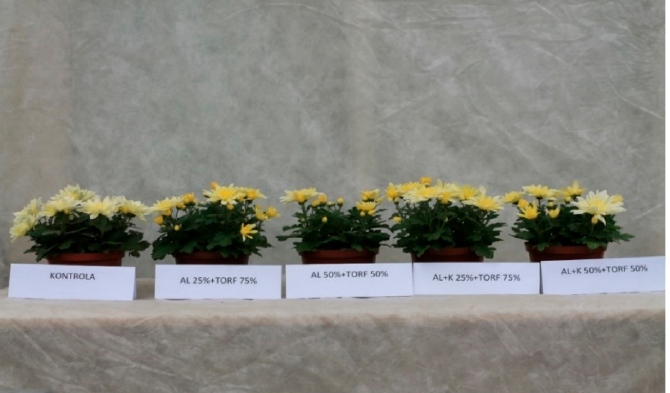
Figure 5. The quality of chrysanthemum (KONTROLA-control, AL 25% + TORF 75%-compost AL 25% + peat 75%, AL 50% + 50% TORF-compost AL 50% + peat 50%, AL + K 25% + 75% TORF-compost AL + K 25% + peat 75%, AL + K 50% + 50% TORF-compost AL + K 50% + peat